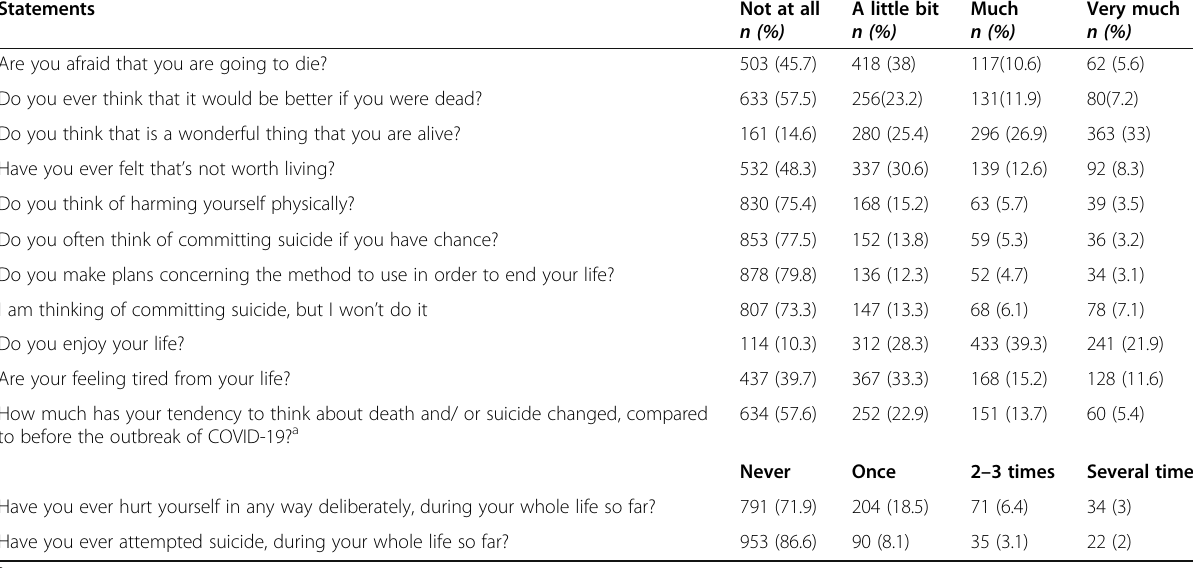
Table 3 Frequency table of responses to the individual scale items on Risk Assessment Suicidality